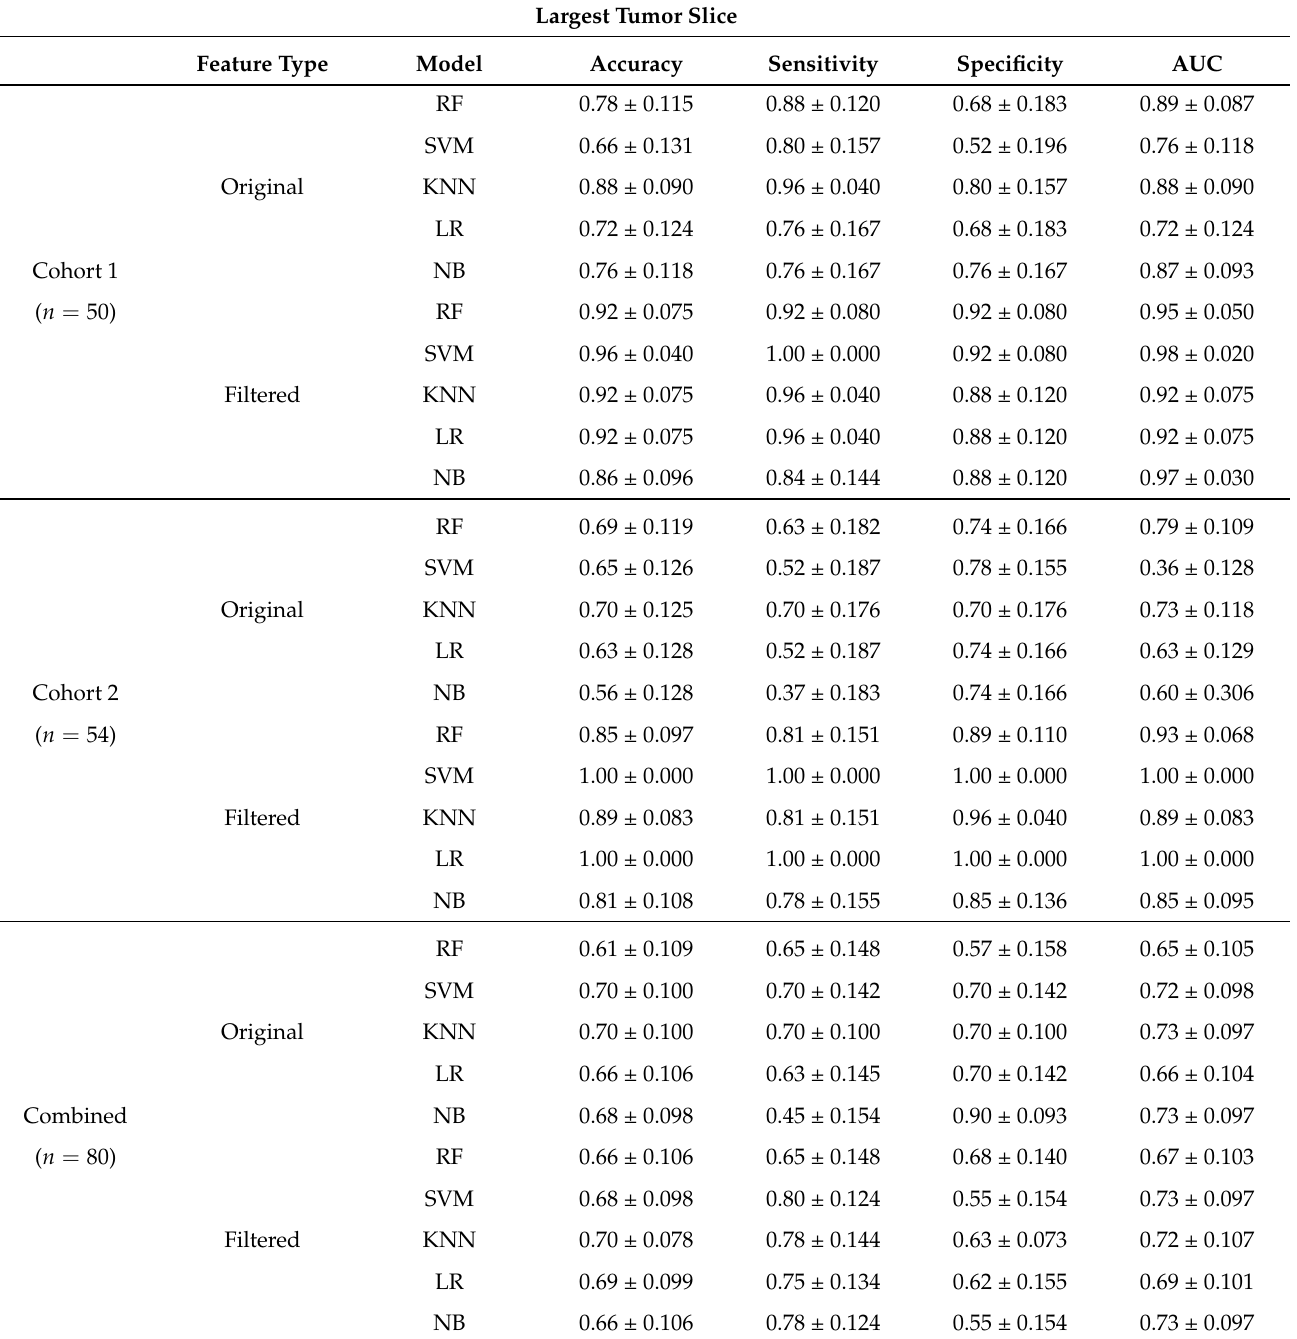
Table 7. Representation of diagnostic performance using largest tumor slice for different